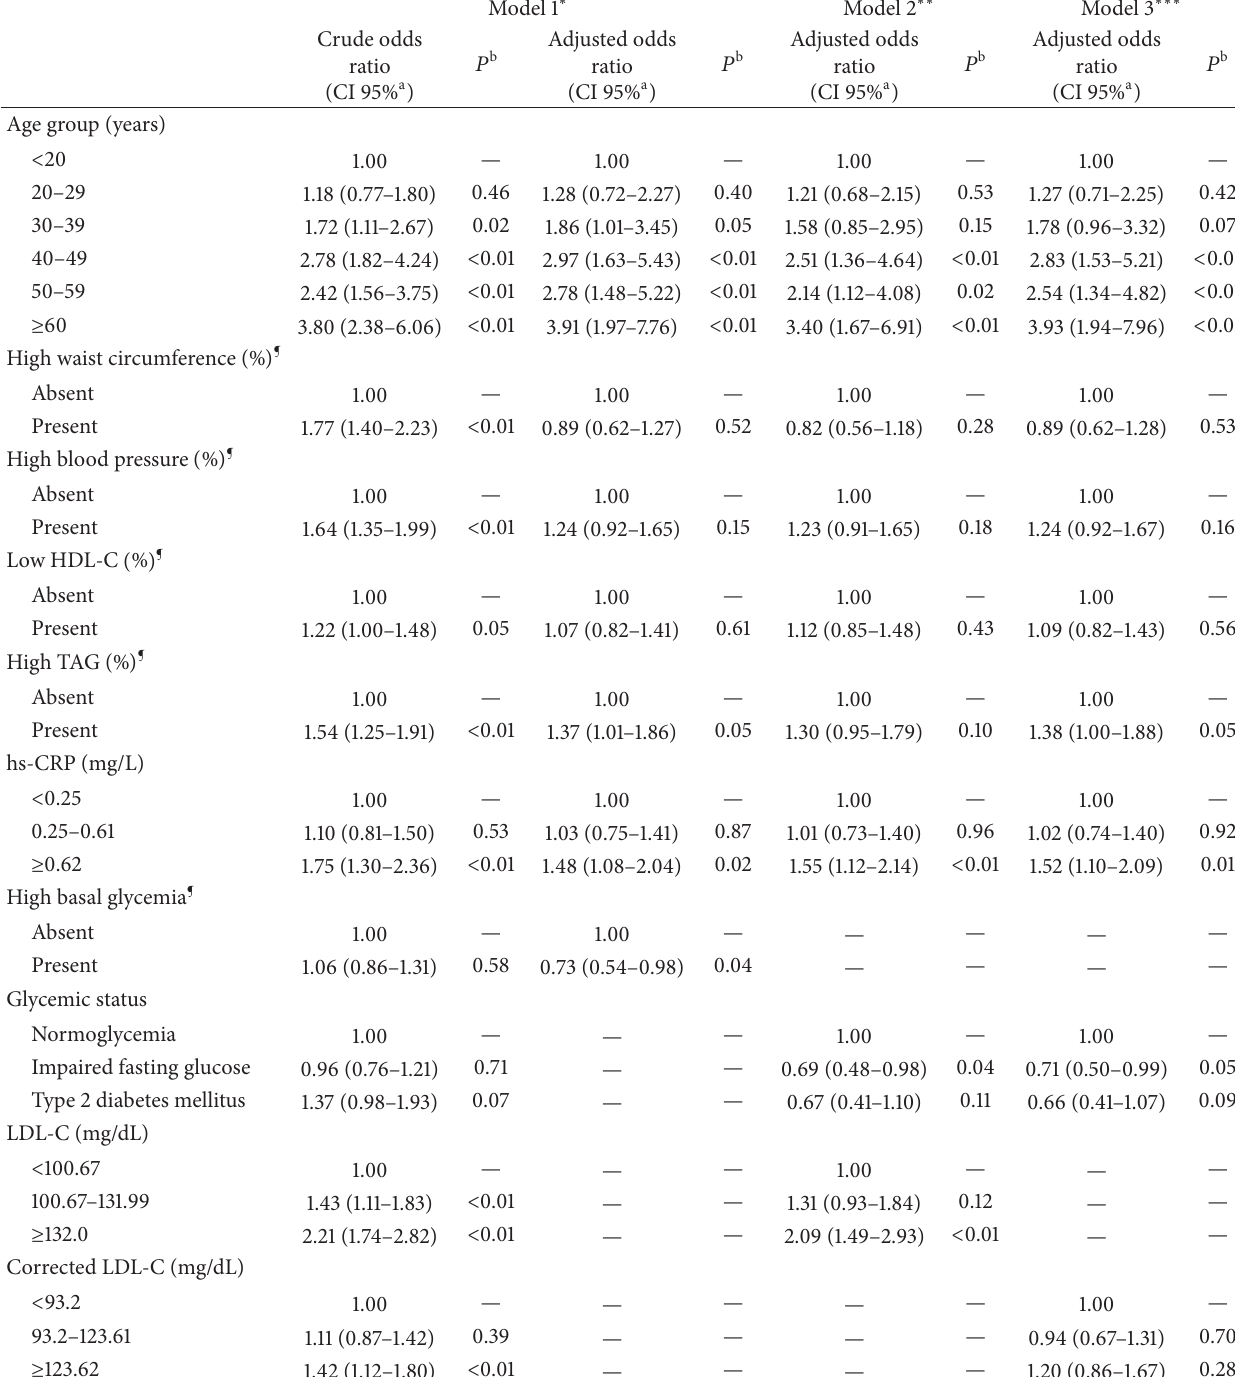
Table 6: Logistic regression models of risk factors for high serum Lp(a) concentration. The Maracaibo City Metabolic Syndrome Prevalence Study, 2013.